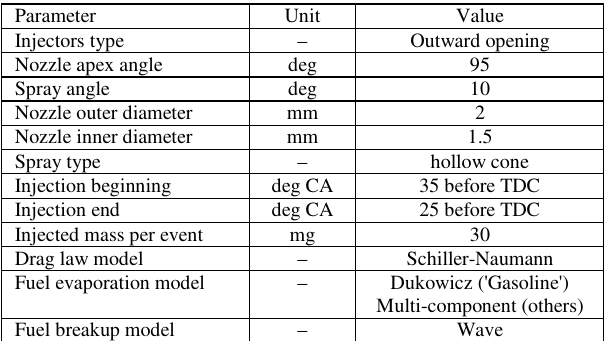
Table 2. The parameters of injectors and